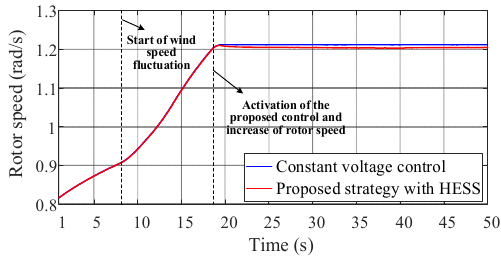
Figure 23. The rotor speed of the DFIG in case II.